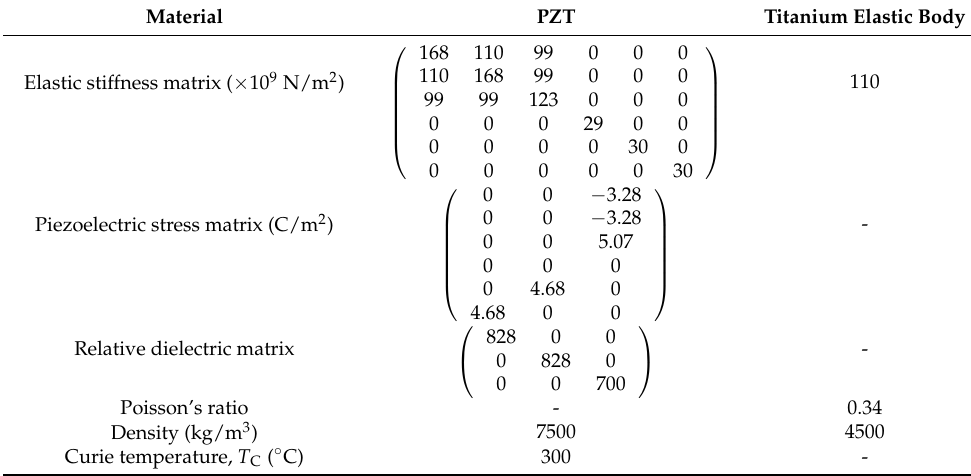
Table 1. Material constants for simulation ( t = 20 ◦